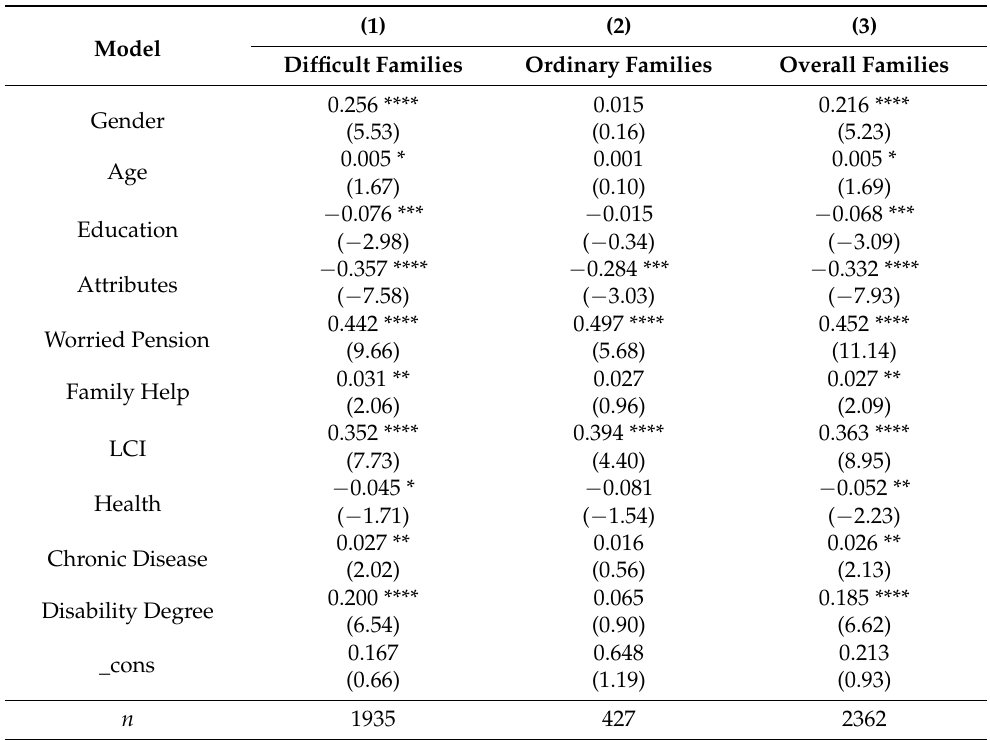
Table 4. Comparison of the results of factors influencing the needs of elderly care services in difficult families and ordinary